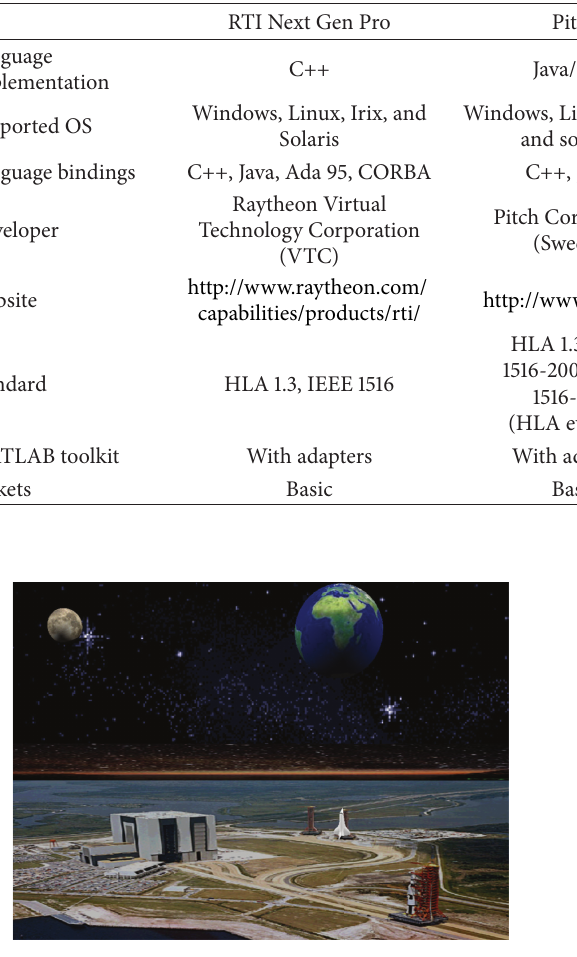
Figure 3: JAVA 3D space exploration environment created for the VTB and VRML/X3D object (the space